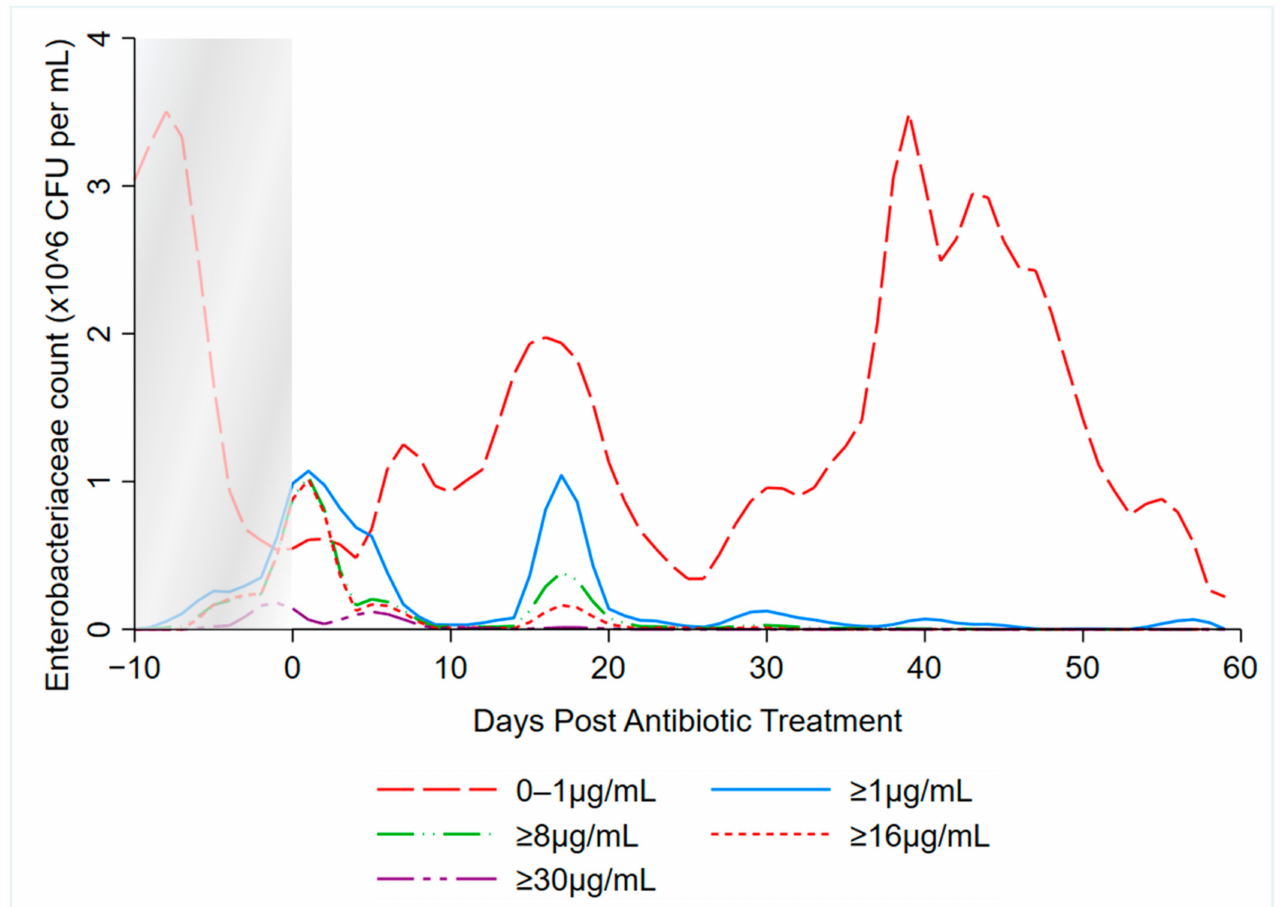
Figure 3. Kernel-weighted local polynomial smoothed regression plots for Enterobacteriaceae counts in cows treated with systemic antimicrobial drugs by days post-antibiotic treatment. Data between − 10 to 0 days post-antibiotic treatment combine cows currently receiving treatment and pre-treatment cows, due to varying treatment durations (indicated by the shaded